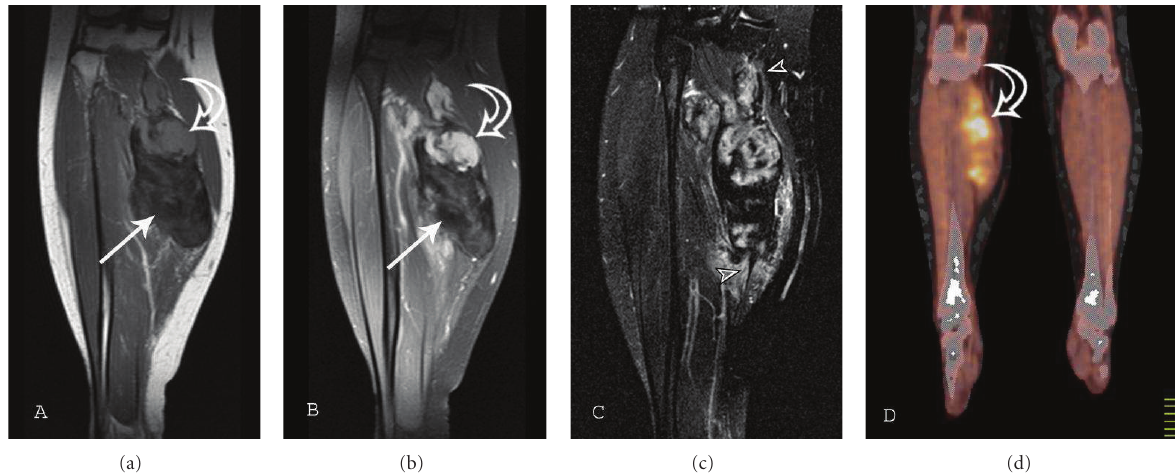
Figure 7: Extraabdominal fibromatosis of the medial soleus muscle: a 22-year-old female presents with a painless soft tissue mass of the right calf. (a) Coronal T1-weighted (TR550/TE12) and (b) coronal T1-weighted (TR552/TE12) postcontrast fat suppression sequences demonstrate a heterogeneous predominately low T1-weighted signal lesion of the medial soleus muscle (arrow). (c) Coronal T2-weighted (TR3000/TE70) image with fat saturation reveals the lesion growing along the fascia (fascial tail sign) (arrowheads) at the proximal and distal aspects of the lesion. (d) Coronal PET-CT fusion image reveals heterogeneous FDG uptake, which is the most common reported pattern of deep fibromatosis. Note the intermediate T1-weighted signal with marked enhancement corresponding to an area of high cellularity (curved arrows on (a) and (b)) at the proximal aspect of the lesion. This immature area demonstrates higher FDG uptake (curved arrow on (c)).